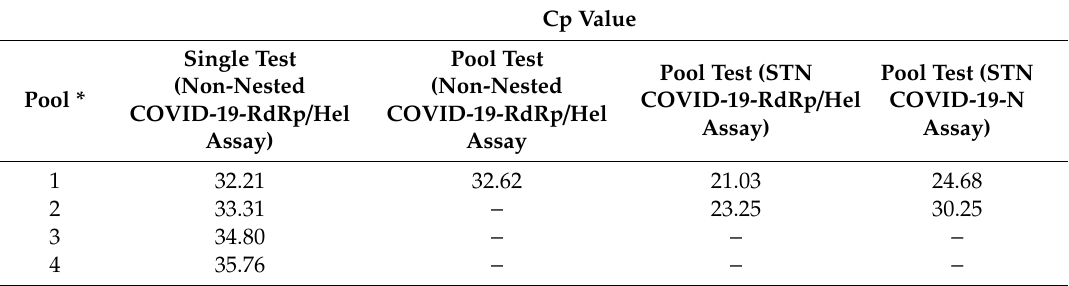
Evaluation of four pooled samples using the in-house developed non-nested COVID-19-RdRp / Hel and STN real-time RT-PCR